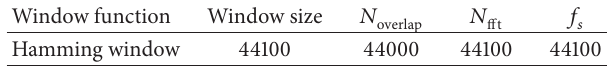
Table 2: Settings of STFT.